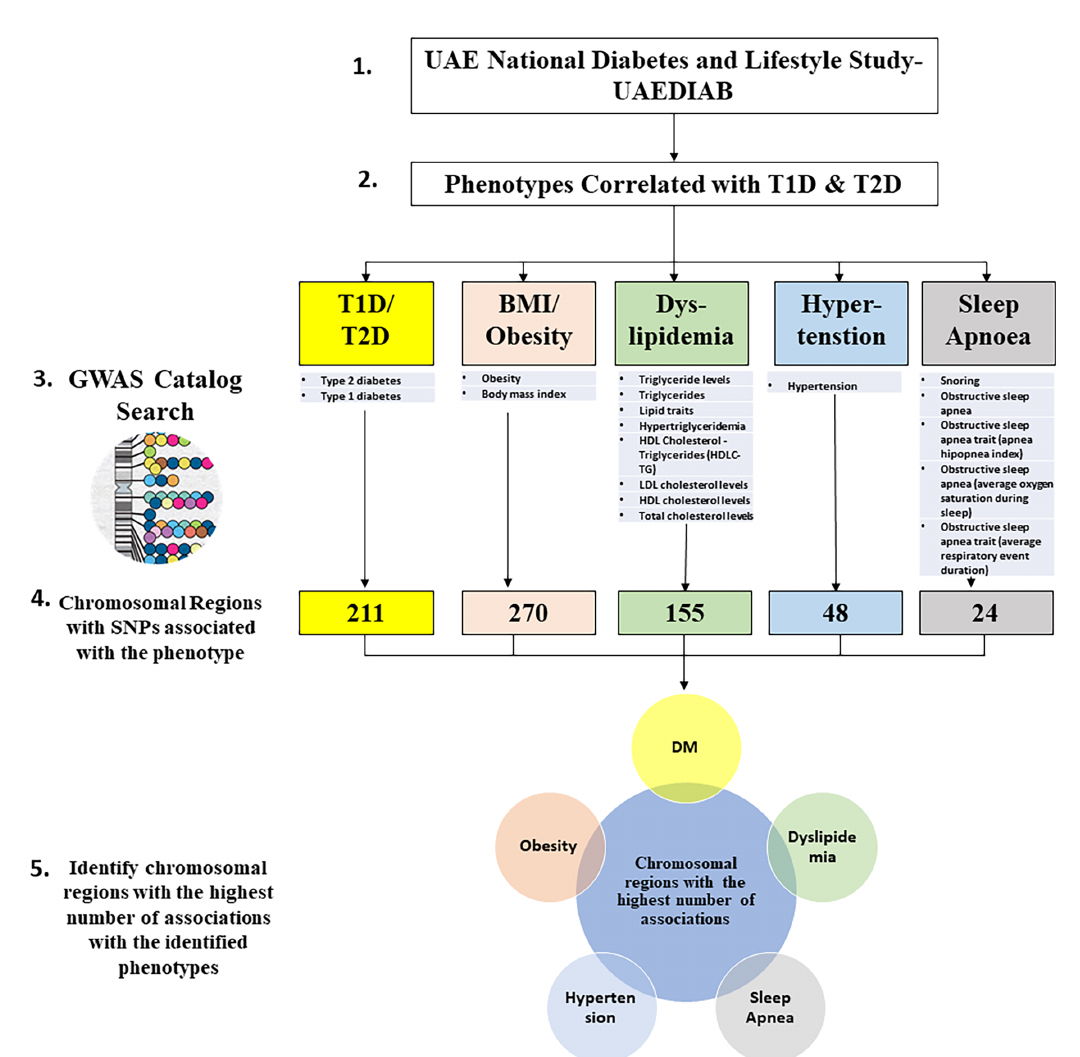
Figure 1. Flowchart to identify hot spots of chromosomal regions associated with single nucleotide